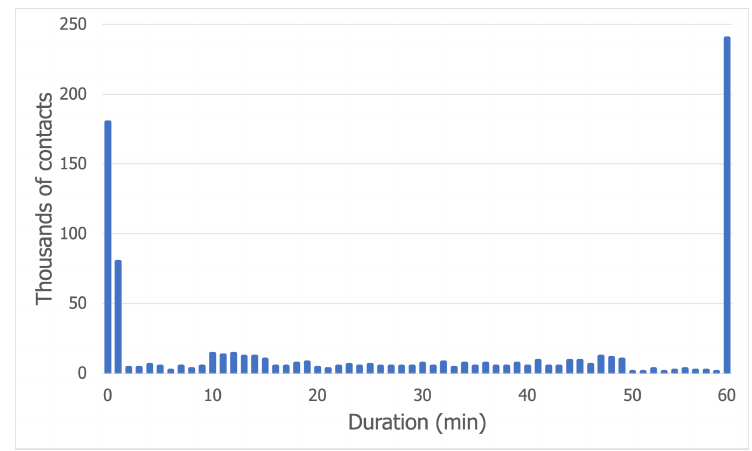
Figure 7. Contact duration distribution for the Wi-Fi Direct